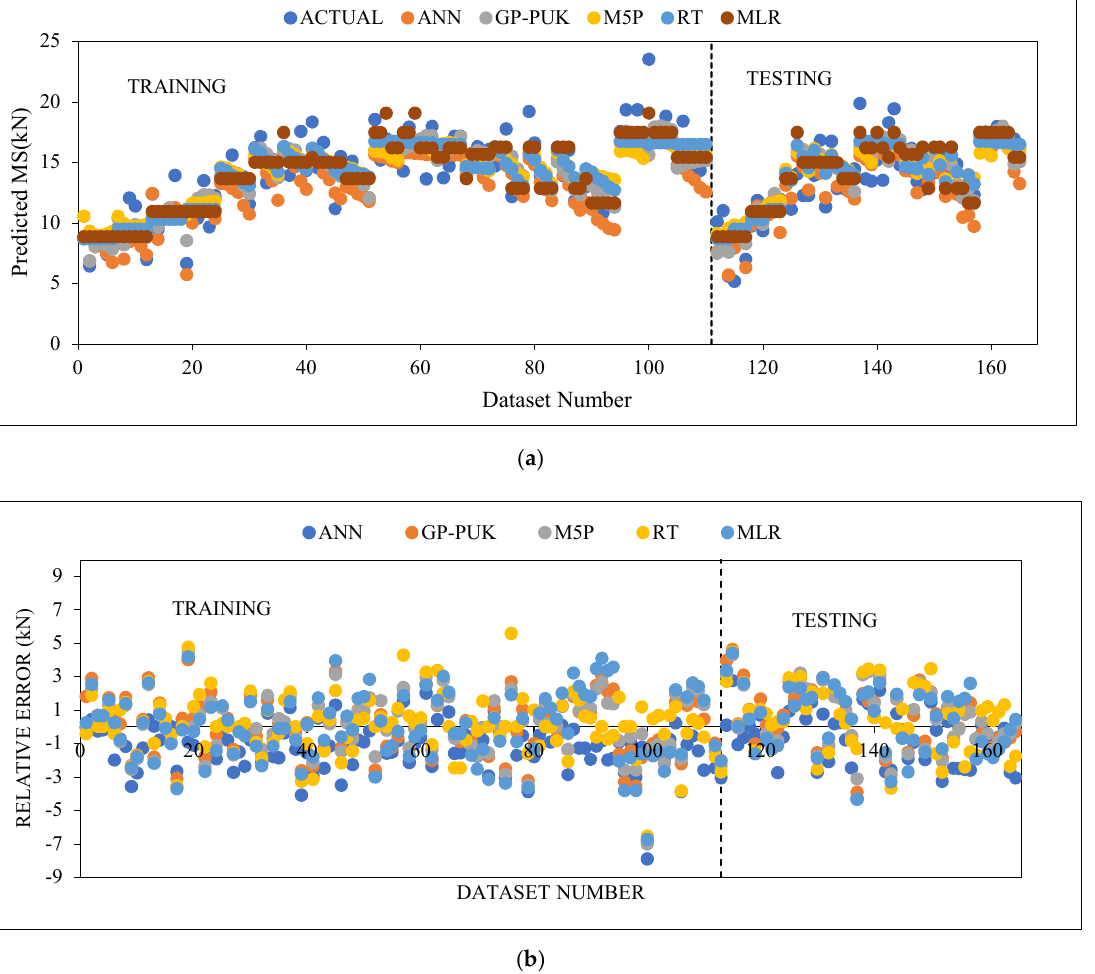
Figure 12. ( a ) Predicted MS of all models applied for training and testing stages. ( b ) Relative error with dataset using all models for training and testing stages. Table 13. Quartile values using actual and predicted values of all applicable models for the testing stage.